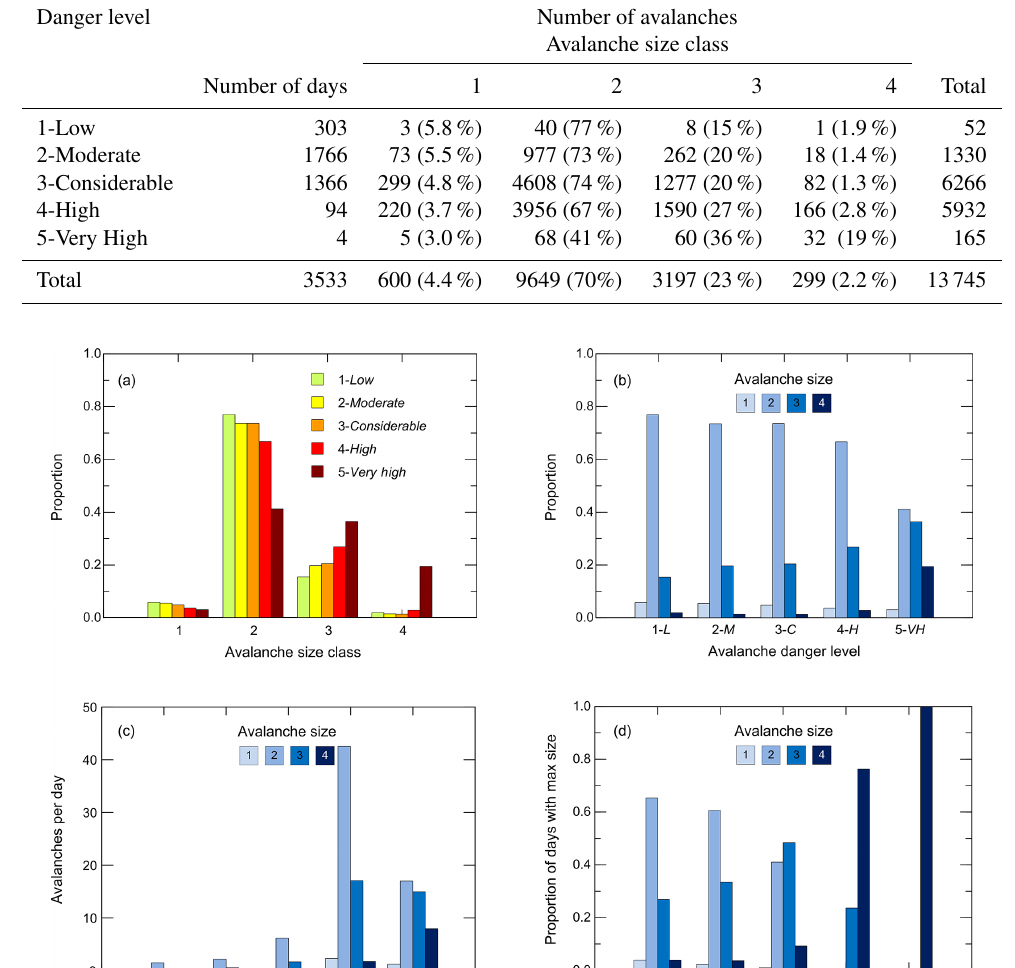
Table 3. Frequency of avalanche size per danger level (proportion in percent).